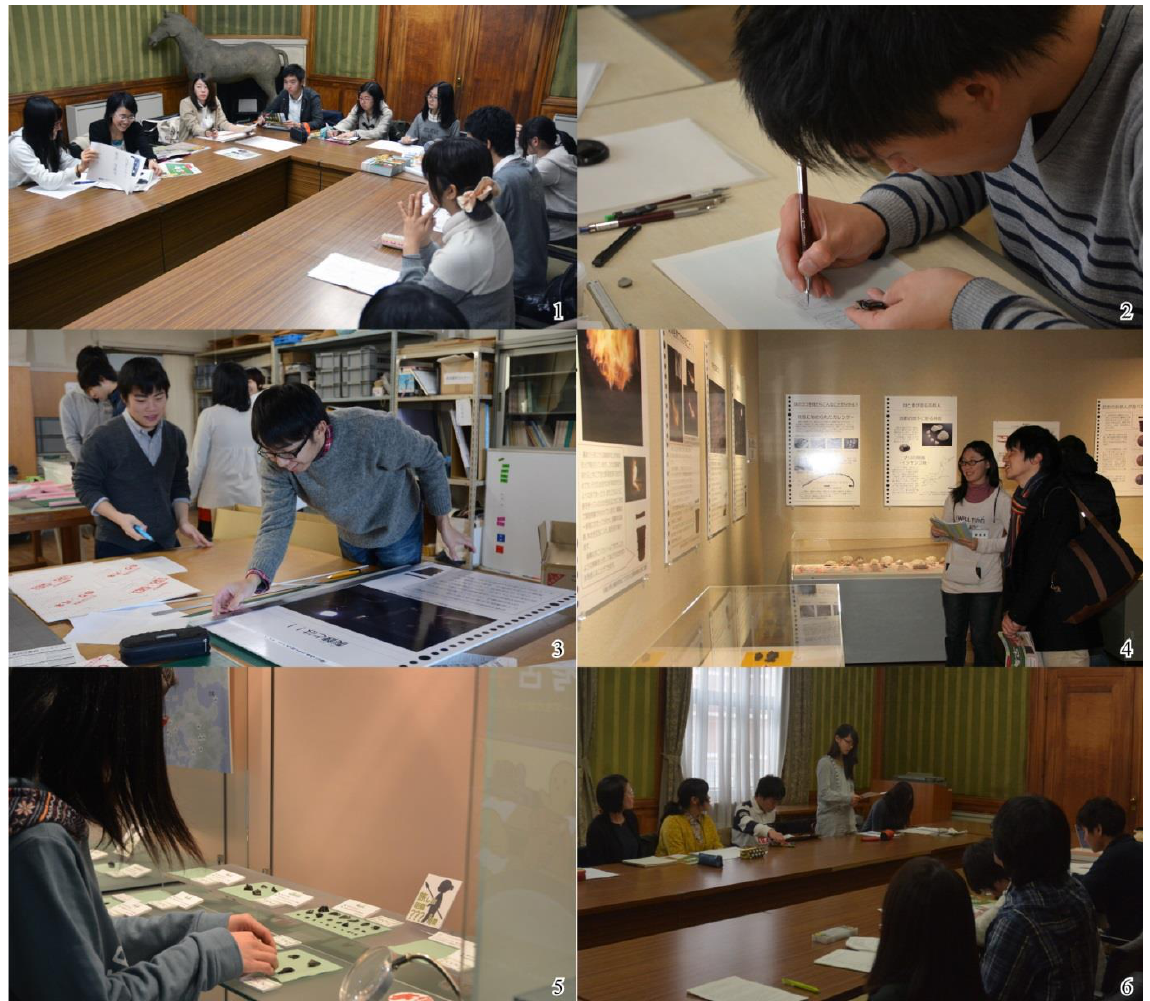
Figure 1. Activities of the students and young researchers involved in the exhibition. 1. Planning meeting. 2. Observing and making scale drawings of artifacts. 3. Preparation for the exhibition. 4. A gallery talk. 5. Fine adjustment of exhibits. 6. Review